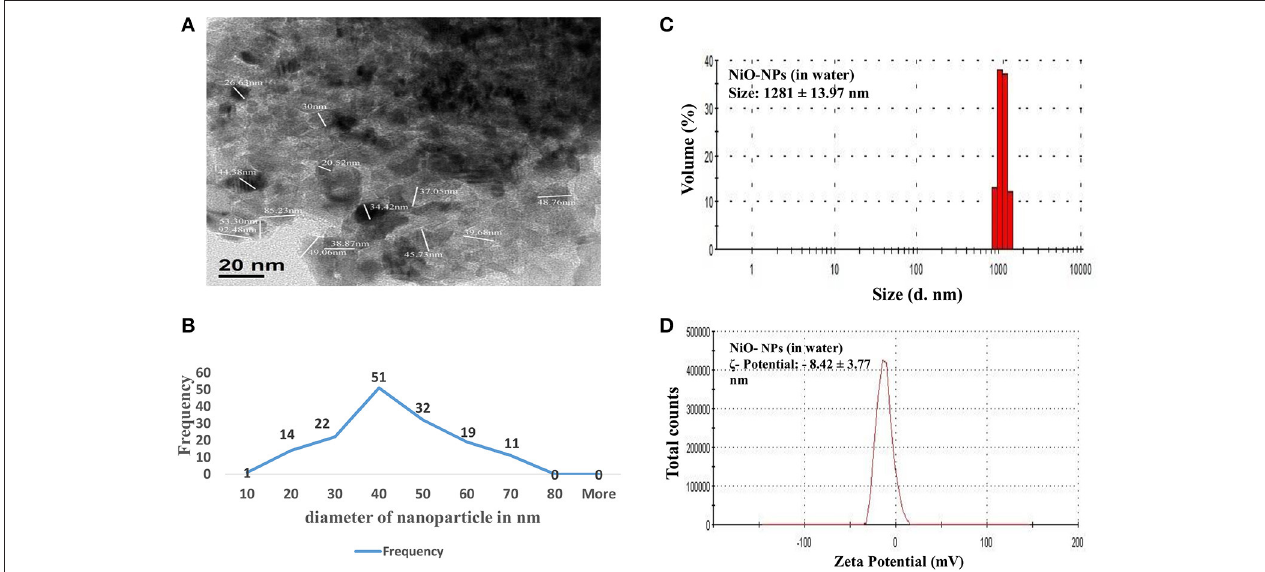
Figure 3 (Supplementary Figures 2–4)